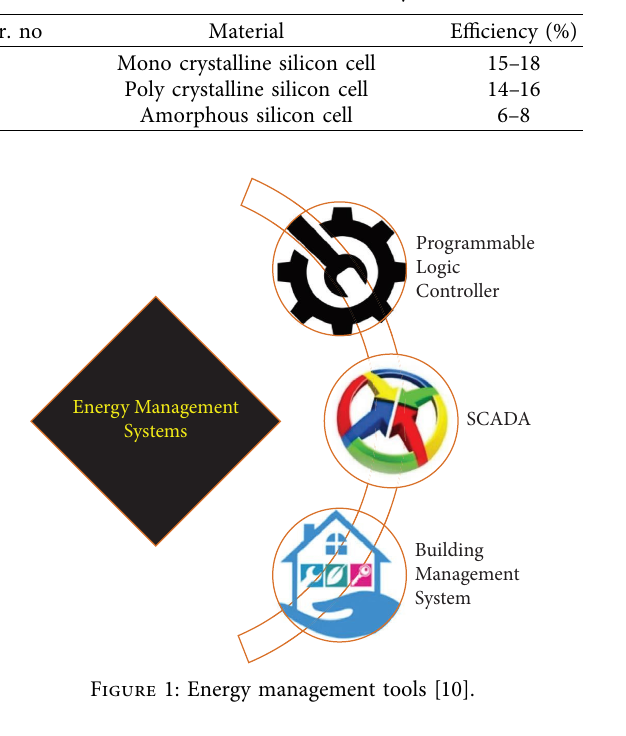
Figure 1: Energy management tools [10].